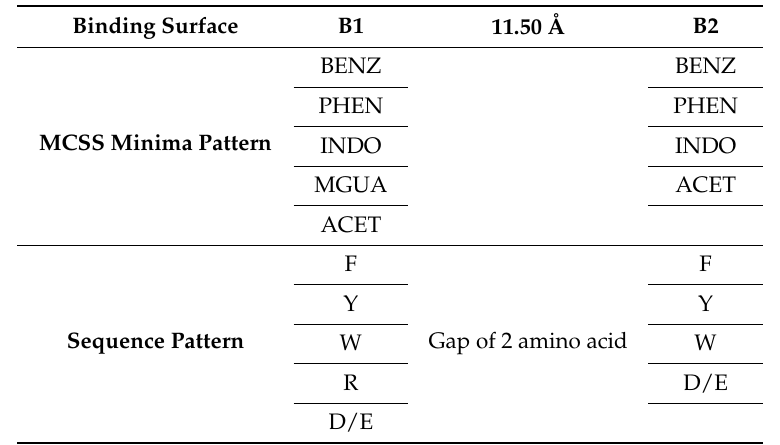
Table 4. Distribution of key minima and the derived sequence pattern for the binding epitope peptides to the antibody CR9114. A sequence pattern of “X-J” (X = R,FW,Y,D/E, and J = F, W,Y,D/E) was